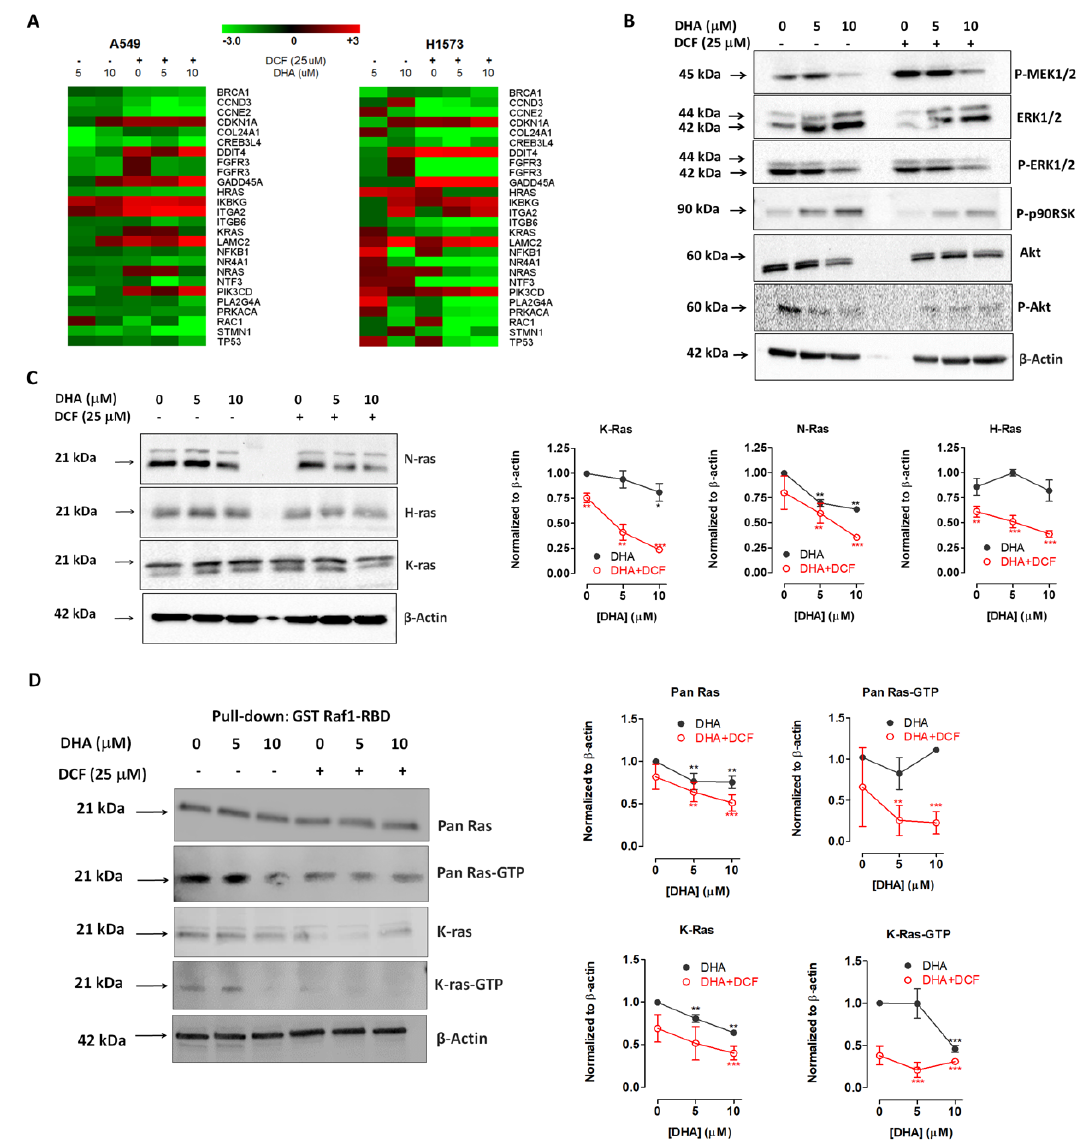
Figure 8. Co-treatment with diclofenac (DCF) and DHA alters the expression of proteins in the Ras / MEK / ERK and PI3K / AKT pathways. ( A ). Heatmap illustrating changes in mRNA expression for Ras / MAPK and PI3K / AKT genes altered in A549 and NCI-H1573 cells exposed to DHA (5 and 10 µ M) alone or with DCF (25 µ M) for 48 h as determined by the nCounter PanCancer Pathways gene expression analysis. The heat map of gene expression with fold changes of ≥ ± 2 with key roles in the Ras / MEK / ERK and PI3K / AKT pathways was generated using the MultiExperiment Viewer (MeV v4.9.0, http: // www.tm4.org) (red indicates upregulated genes; green indicates downregulated genes). Western blot analysis showing the expression of ( B ). phospho-MEK1 / 2, phospho-p44 / 42 MAPK (Erk1 / 2), phospho-p90RSK phospho-Akt, and Akt (pan); ( C ). K-Ras, N-Ras, and H-Ras in A549 cells after treatment with DHA (0–10 µ M) and DCF (25 µ M) for 48 h. ( D ). Western blot analysis of GTP-bound K-Ras and pan Ras following pull-down with the GST-Raf1-RBD fusion protein, which binds only active Ras, indicated decreased Ras activity after co-treatment of A549 cells with DCF (25 µ M) and DHA (5 and 10 µ M) for 48 h. Normalized densitometric data was used to generate the graphs shown in GraphPad Prism 5.0 (La Jolla, CA, USA). Statistical significance (* p < 0.05; ** p < 0.01, *** p < 0.001) was determined by comparing the mean of each treatment group to untreated control using a 1-way ANOVA and post-hoc Dunnett’s test. Detailed information about western blot can be found at Figure S2.